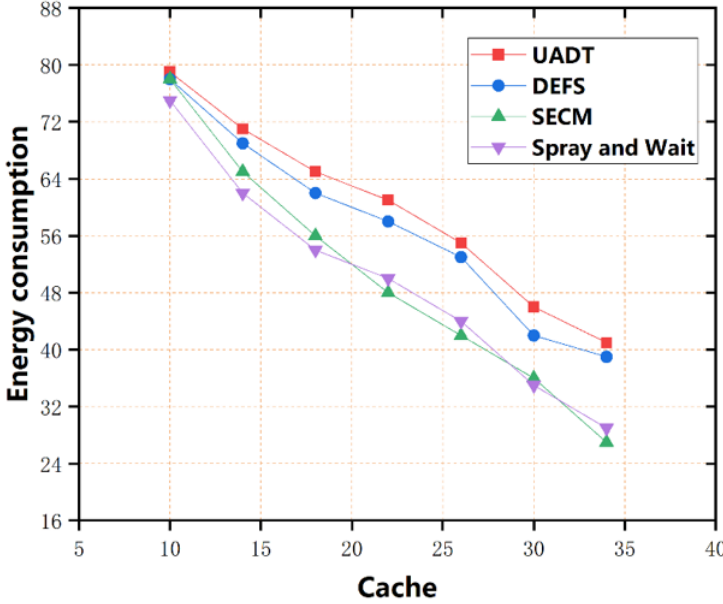
Figure 5. Relationship between overhead on average and cache.